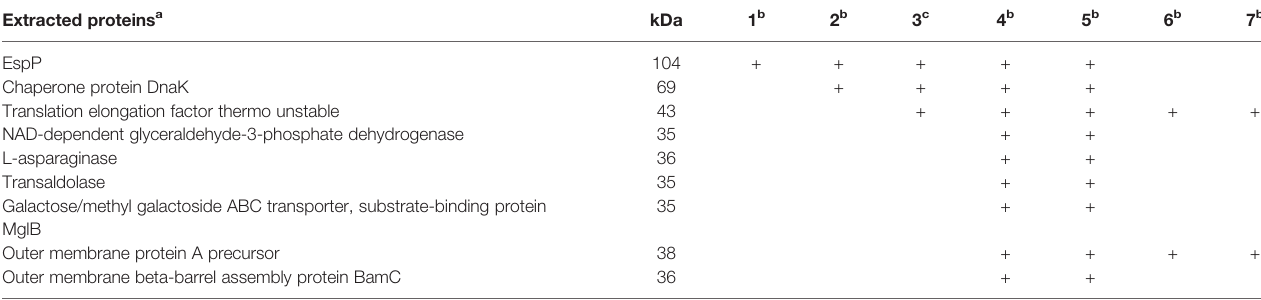
Outer membrane protein A precursor